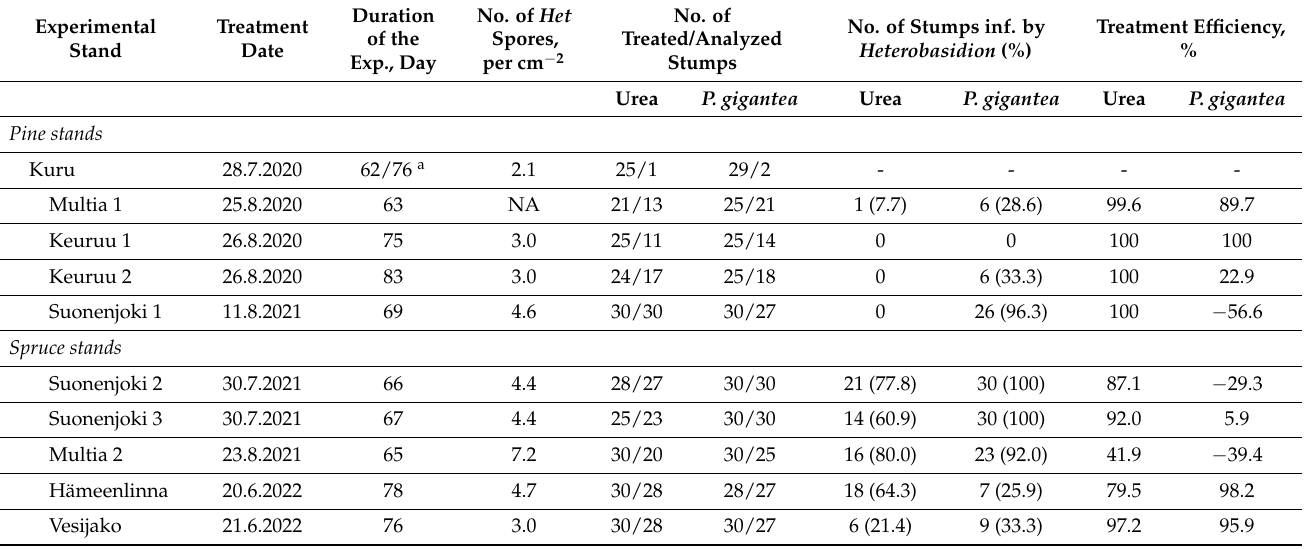
Table 2. Treatment date and duration of the experiment; inoculum density (number of viable Heterobasidion spores per cm − 2 ); the number of treated, analyzed, and infected stumps; and treatment efficacy in experimental stands.